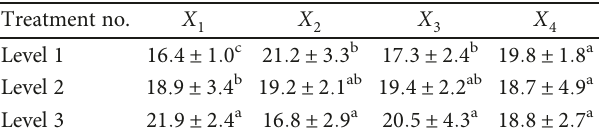
Table 5: Mean and standard deviation for the orthogonal experiment. Treatment no. X 1 X 2 X 3 X 4 Level